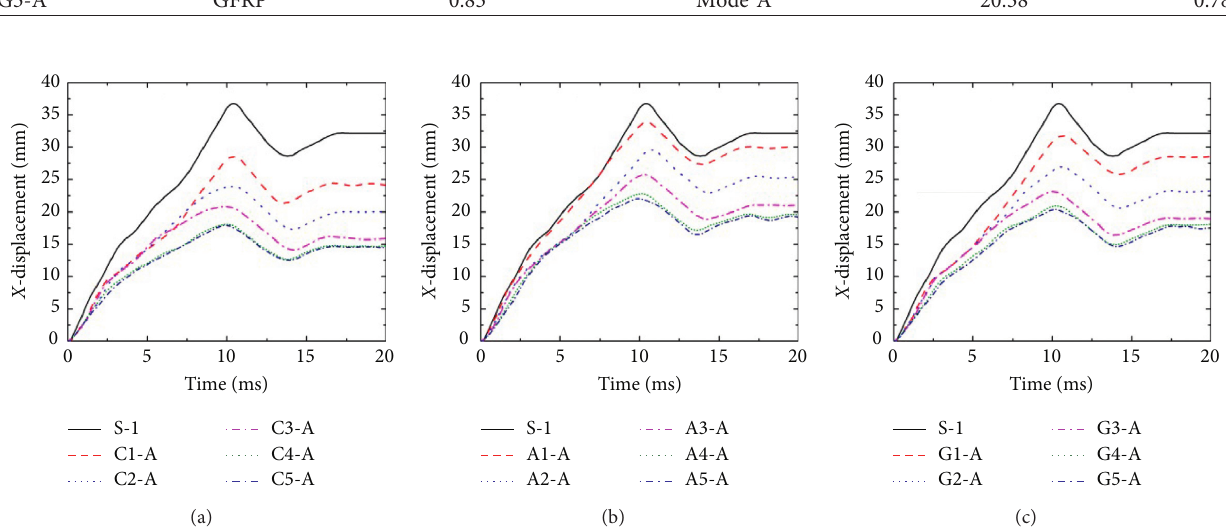
Figure 11: Displacement history curve at midspan of the column retrofitted with different FRP thicknesses. (a) CFRP. (b) AFRP. (c)